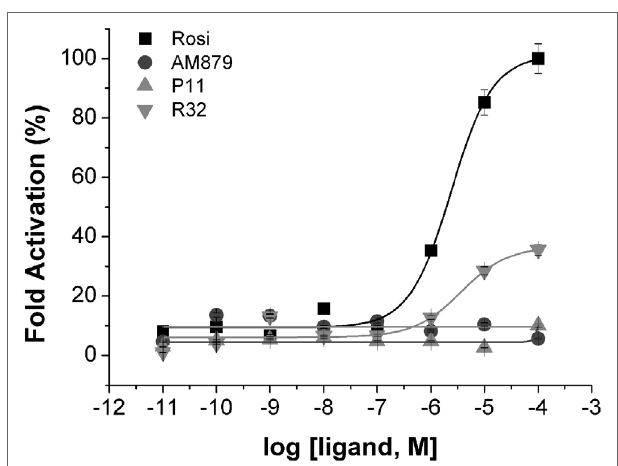
FigUre 3 | Peroxisome proliferator-activated receptor gamma (PPAR γ ) transactivation assay in the presence of the three selected ligands in 293T cells using a GAL4-PPAR γ -LBD reporter gene. Concentration-effect curves were measured for AM-879 (circles), P11 (triangles), and R32 (inverted triangles) ligands. Rosiglitazone (Rosi, squares) was used as positive control. Ligand concentration varied from 0.01 nM to 0.1 mM and the response was presented as fold activation, normalized against the maximal luciferase induction produced by Rosi. Data are the mean ± SEM ( n = 3).